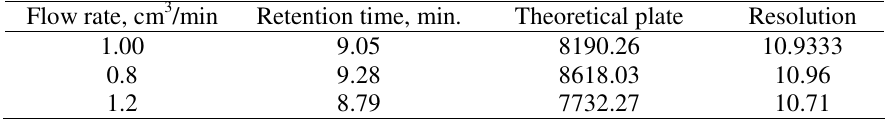
Table 2. Effect of flow rate - methocarbamol